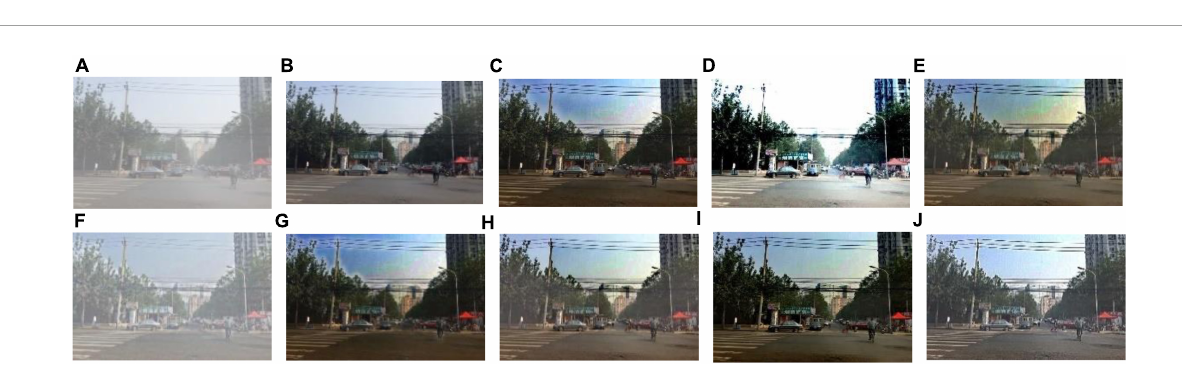
FIGURE12 Experimental results of different methods for Figure 5 : (A) input image; (B) ground truth; (C) dark channel prior; (D) Fattal et al.; (E) Meng et al.; (F) Tarel et al.; (G) Ehsan et al.; (H) Berman et al.; (I) Raikwar et al.; (J)